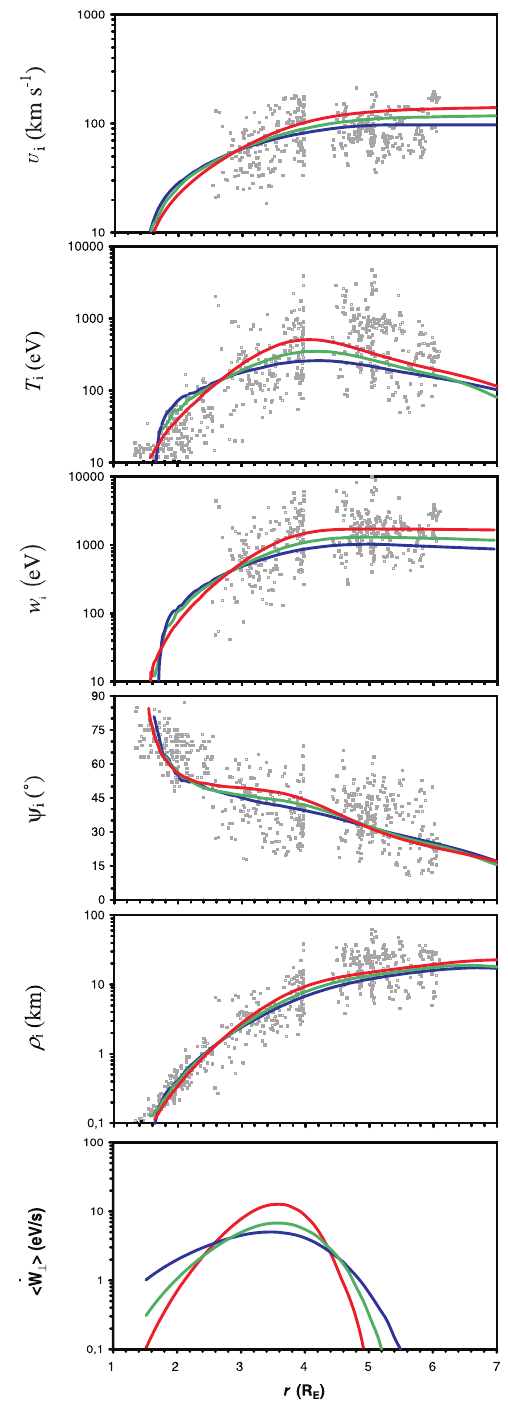
Fig. 7. Comparison along the poleward edge of the cusp/cleft be- tween scatterplots of O + quantities and those obtained from nu- merical simulations for a perpendicular wavelength of 50km and different heating profiles. The green, blue, and red curves are as- sociated with runs 3,5, and 6, respectively (see Table 1). The O + quantities are the same as those of Fig.